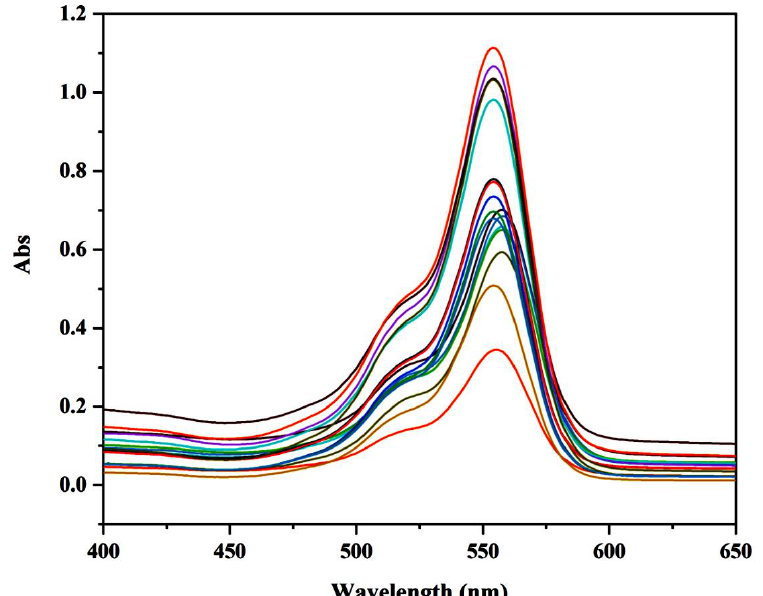
Fig. 5. UV-Vis spectra of Rh B adsorption by p(AMPS-Na + - co -VIm)-Ag (0.1 g hydrogel, pH = 2, 40 ppm, Rh B, 4 h, R. T).